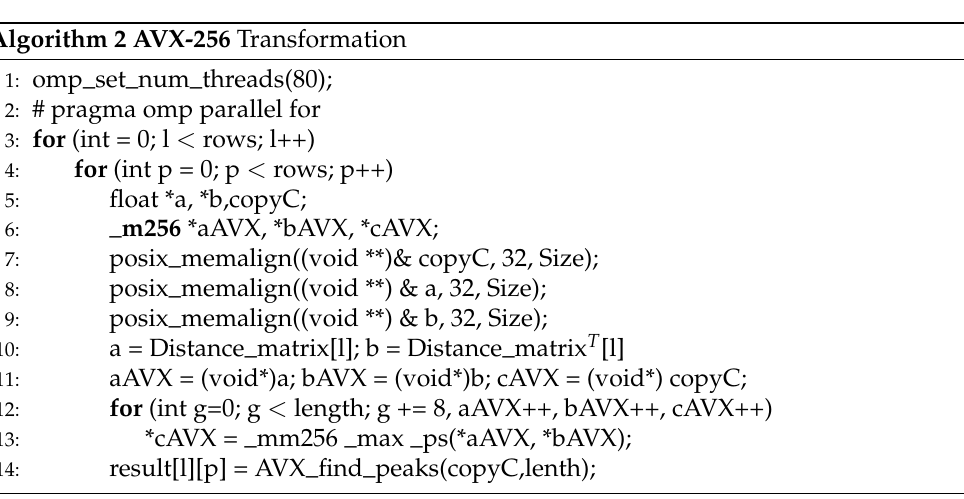
Algorithm 2 AVX-256